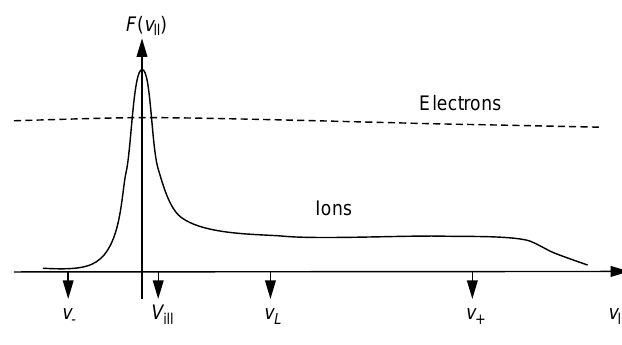
Fig. 2. Schematic picture of the ion distribution and the location of resonant velocities,